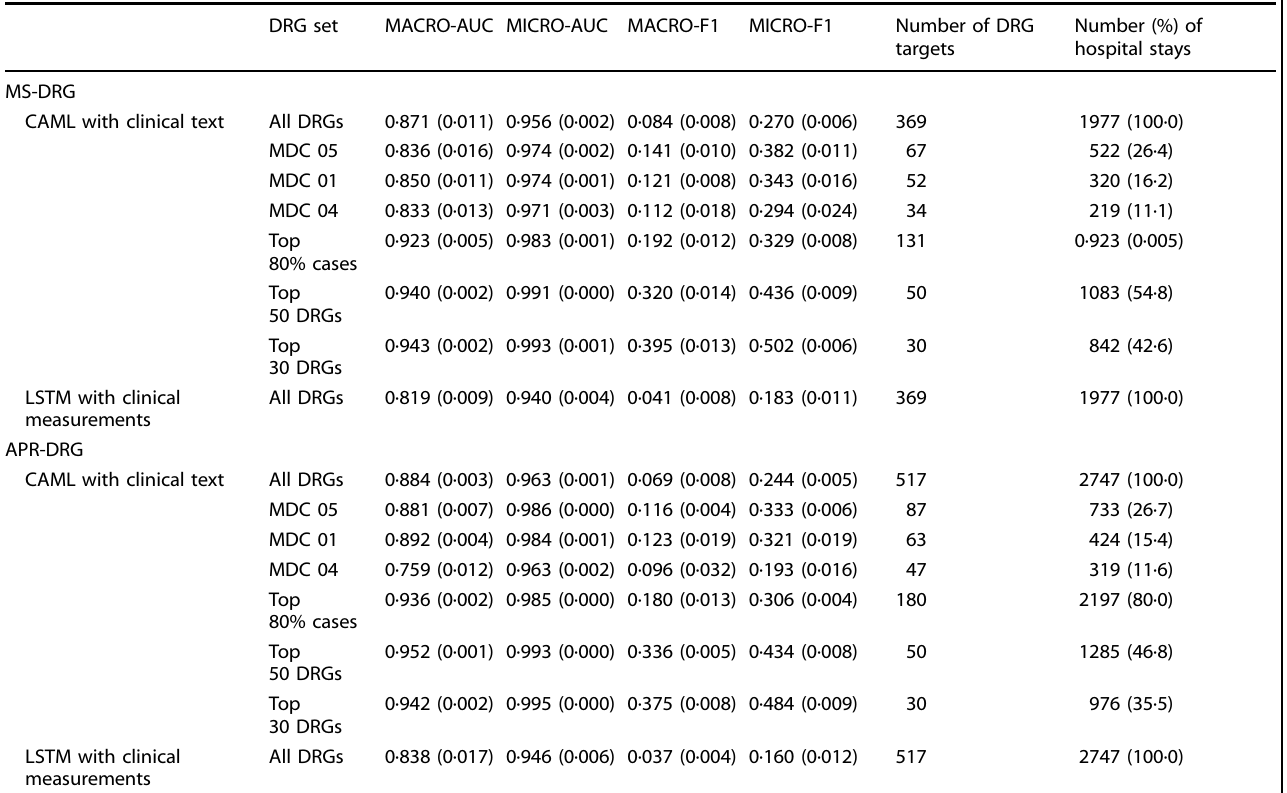
Table 2. Main results on DRG prediction.